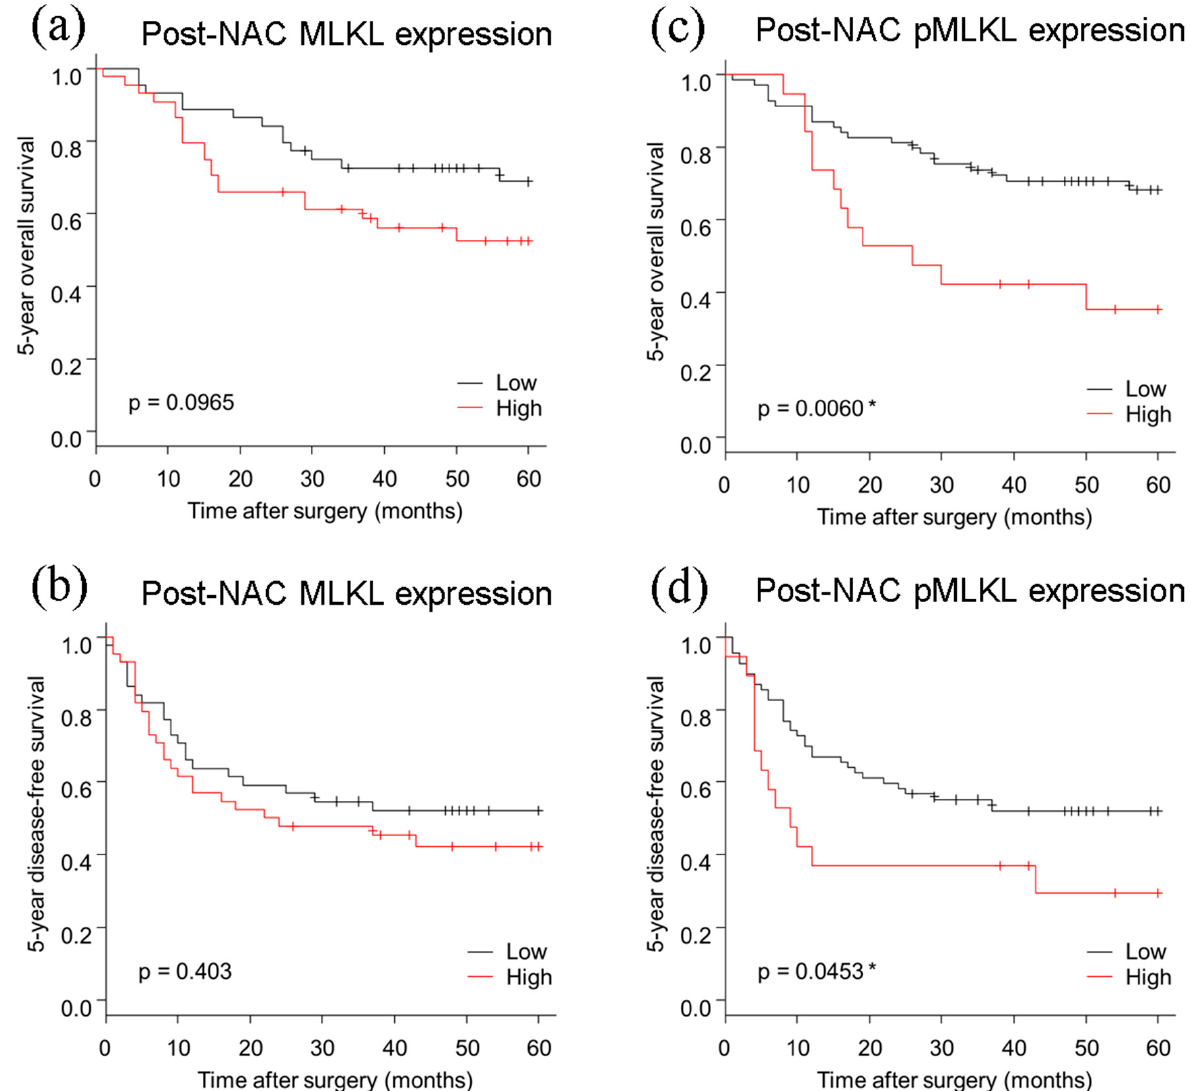
Figure 2. Kaplan–Meier curves based on post-NAC MLKL and post-NAC pMLKL status. ( a , b ) no significant difference was detected in post-NAC MLKL status for the 5 year OS and the 5 year DFS. ( c ) The 5 year OS was significantly worse in patients with high pMLKL than in those with low pMLKL status. ( d ) The 5 year DFS was significantly worse in those with high pMLKL status than in those with low pMLKL status. OS, overall survival; DFS, disease-free survival; NAC, neoadjuvant chemotherapy. * Statistical significance. Table 2. Univariable analysis of patients’ 5 year overall survival.